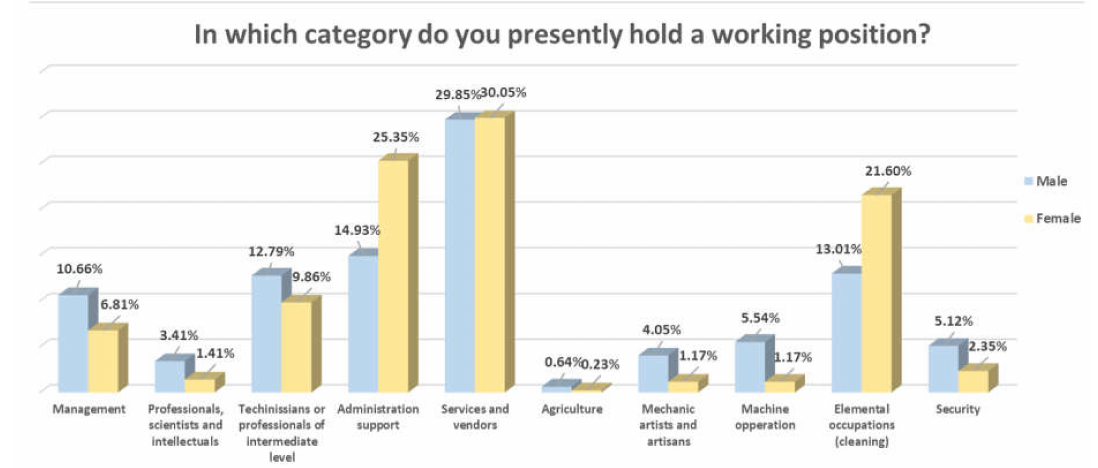
Figure 2. Category in which workers’ present positions were held.